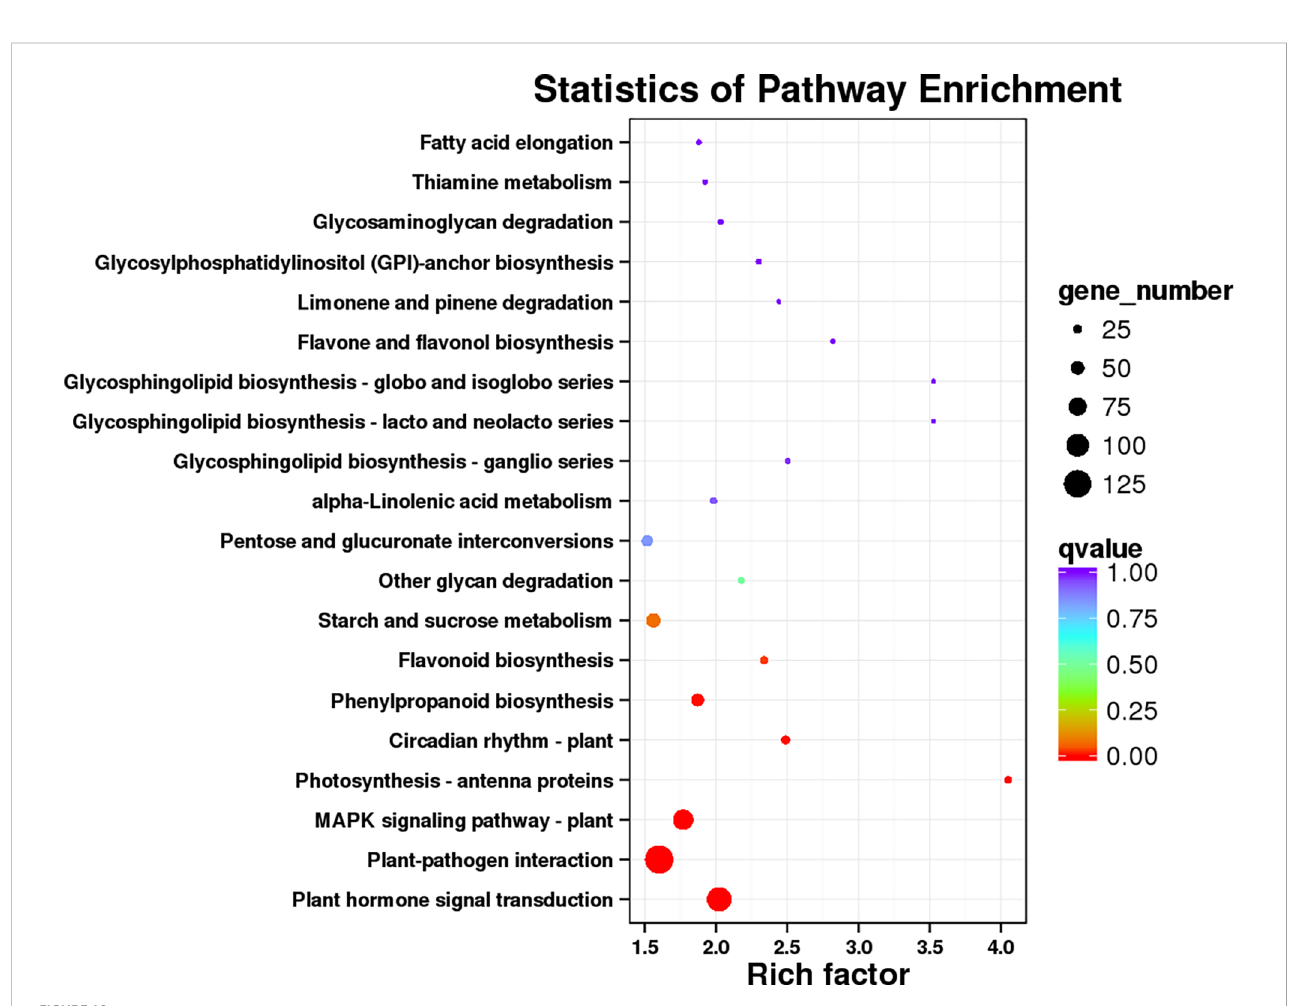
FIGURE 10 The database of KEGG enrichment analysis of